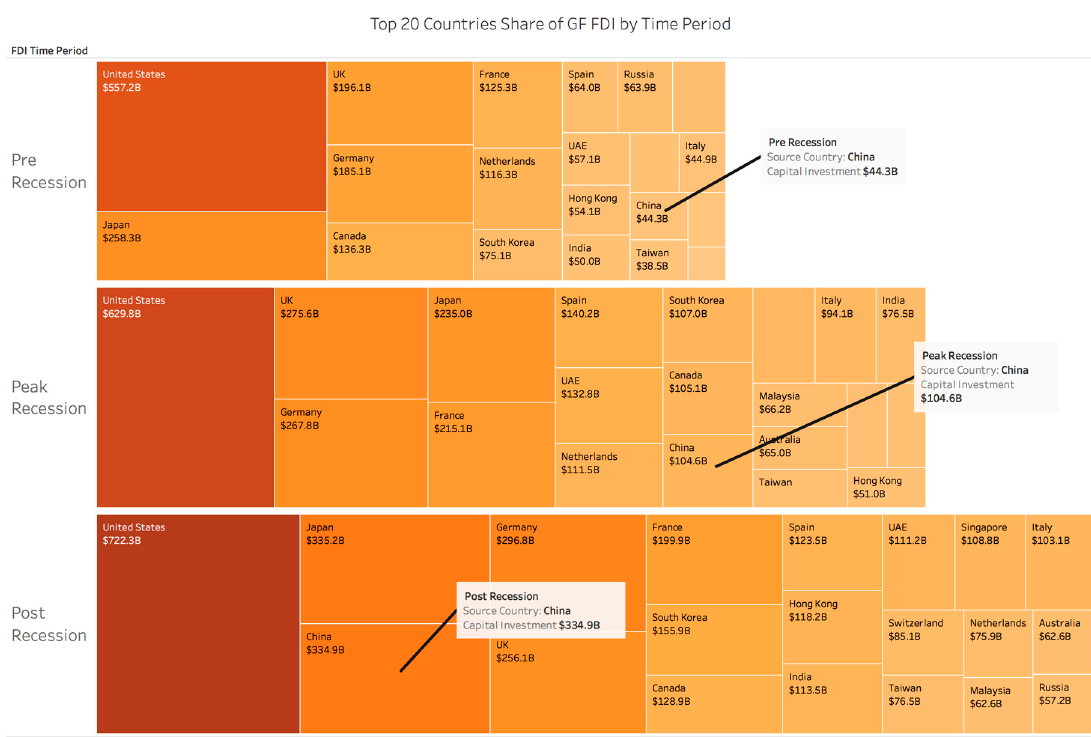
Figure 4. Top 20 countries share of Greenfield FDI sources (1996–2016). China’s ascent is notable in the recession and post-recession phases.